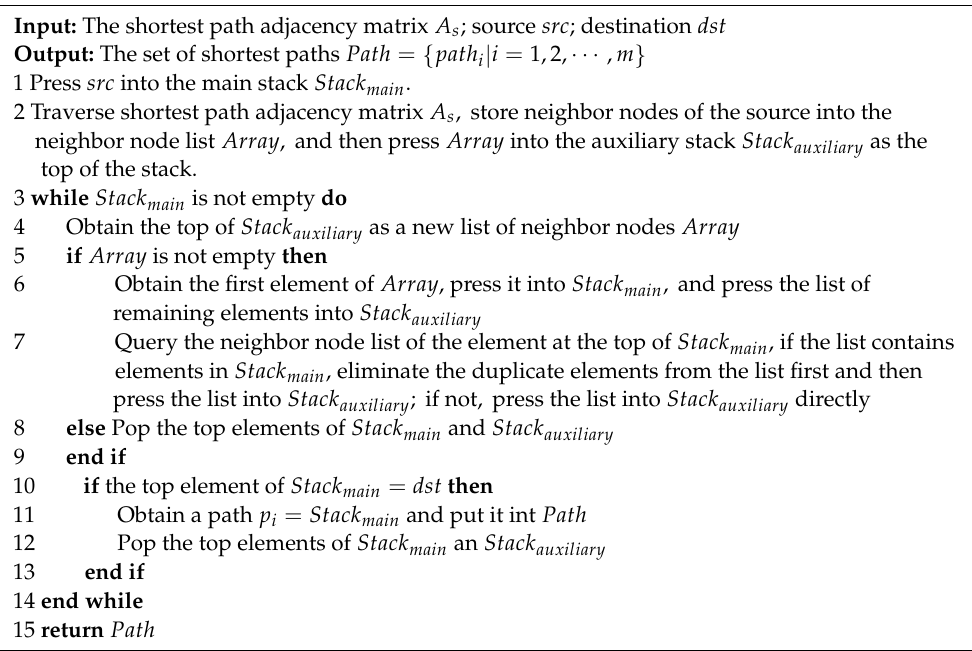
Algorithm 1: Multipath Output